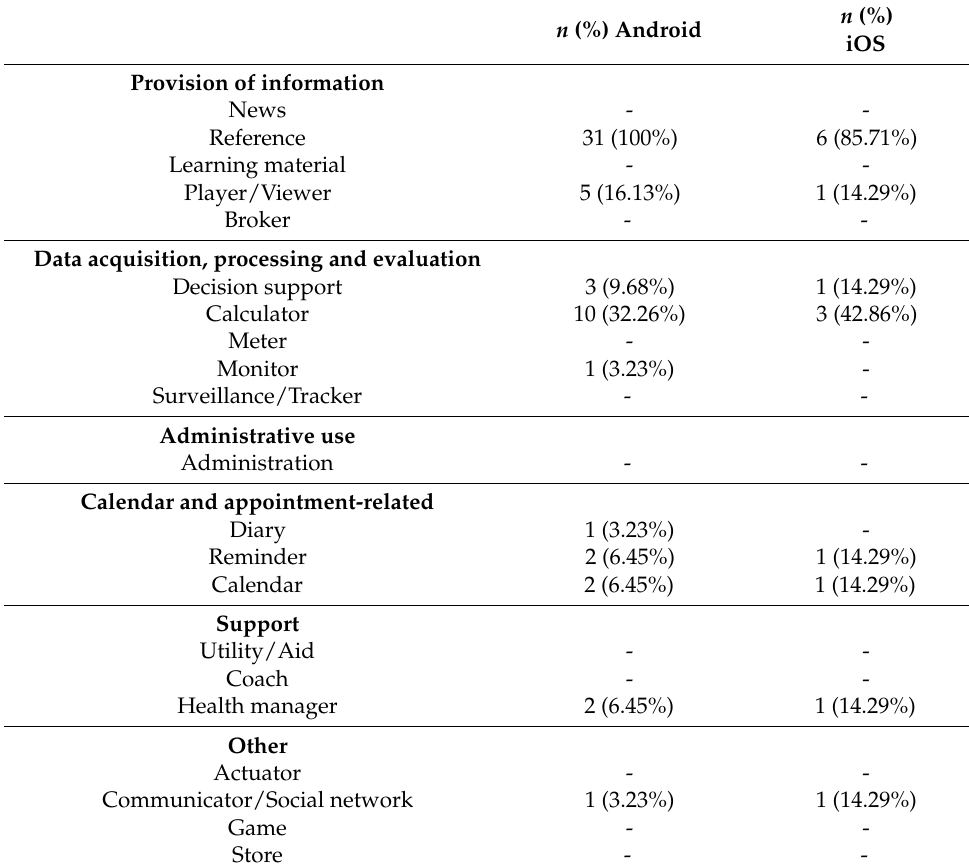
Table A2. Functions of the included